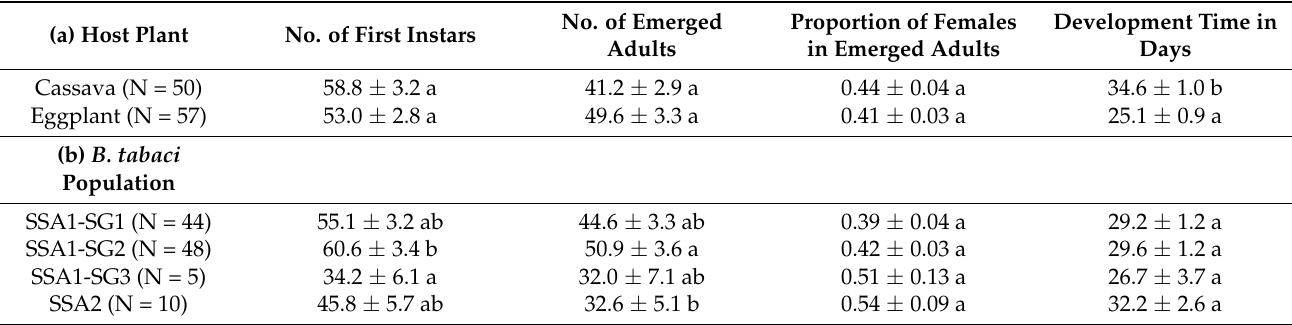
Table 2. Effect of host plant (eggplant and cassava) and B. tabaci populations (SSA1-SG1, SSA1-SG2, SSA1-SG3 and SSA2) on mean number of first instars, emerged adults, proportion of females in emerged adults and development time in the insectary (Natural Resources Institute, Gillingham,